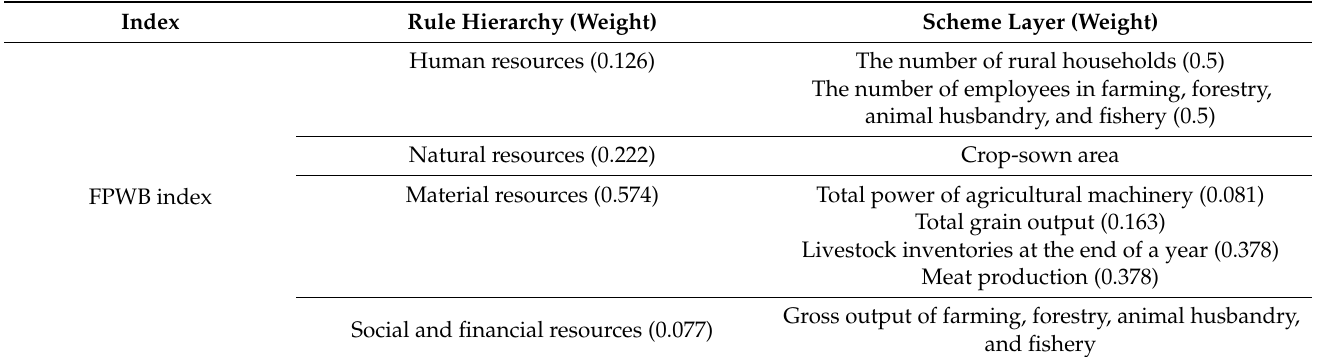
Table 4. Components of the FPWB index on the